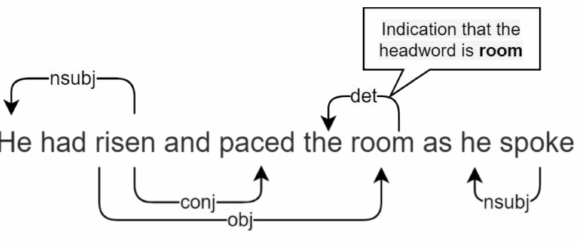
Figure 4. Dependency parsing results for sentence, “ He had risen and paced the room as he spoke ”.